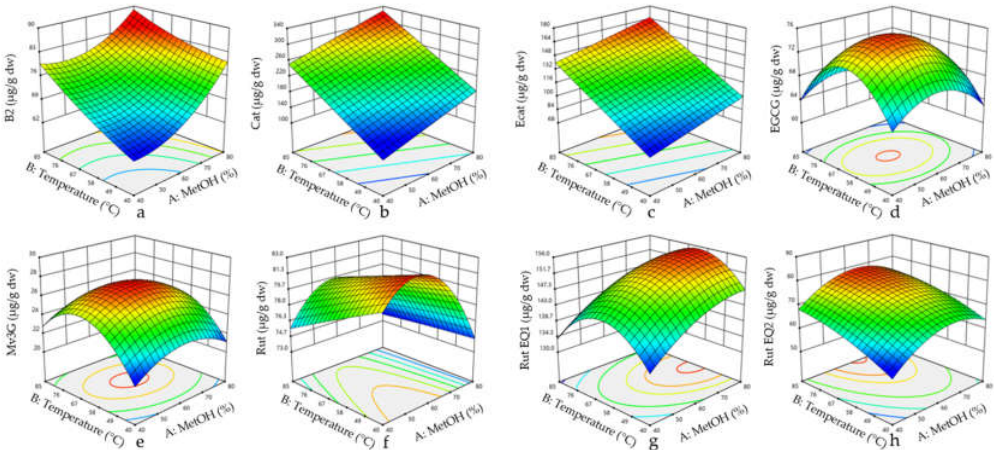
Figure 2. Response surface plots for procyanidin dimer B2 ( a ), catechin ( b ), epicatechin ( c ), EGCG ( d ), malvidin-3- O -glucoside equivalent 3 ( e ), rutin ( f ), rutin equivalent 1 ( g ), and rutin equivalent 2 ( h ) regarding the function of methanol proportion and temperature. Abbreviations: Cat, catechin; Ecat, epicatechin; EGCG, ( − )-epigallocatechin gallate; EQ, equivalent; Rut, rutin; Mv3G, malvidin-3- O - glucoside; and MetOH, methanol.